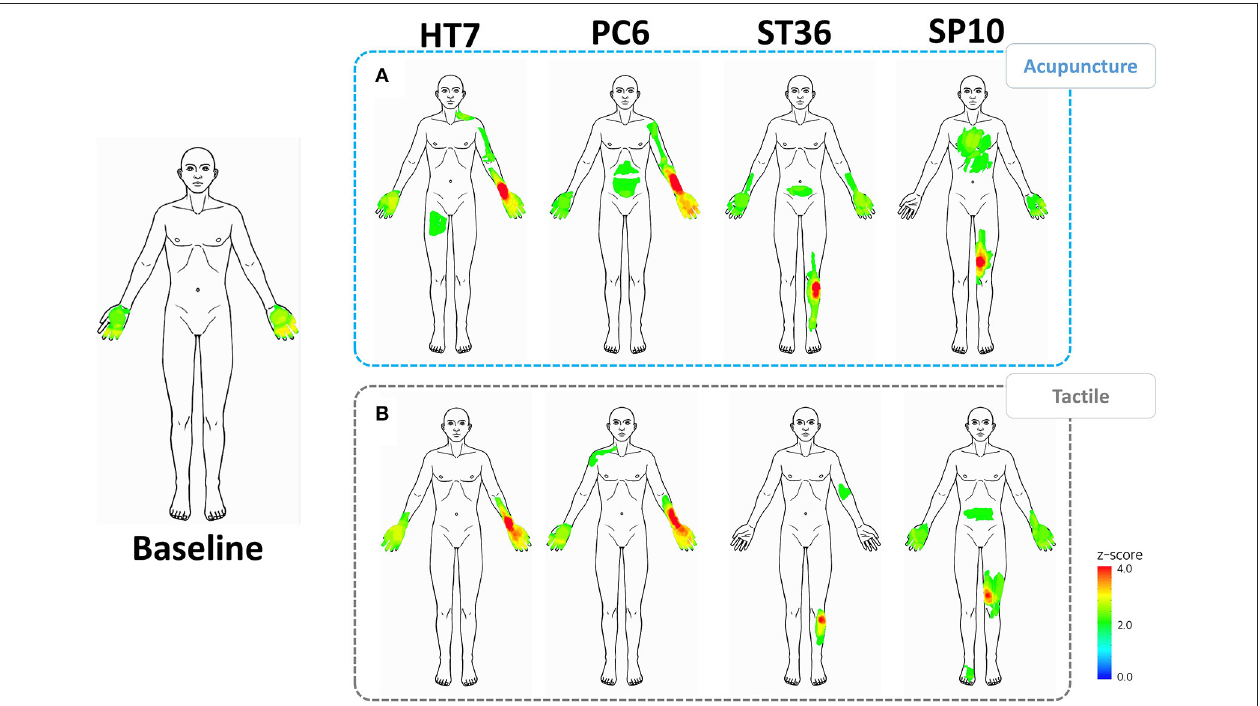
FIGURE 3 | Baseline bodily sensation patterns and spatial patterns of the acupuncture-induced sensations. The left column shows the baseline spatial patterns. (A) spatial patterns following acupuncture stimulation at the HT7, PC6, ST36, and SP10 acupoints. (B) Spatial patterns following tactile stimulation at the HT7, PC6, ST36, and SP10